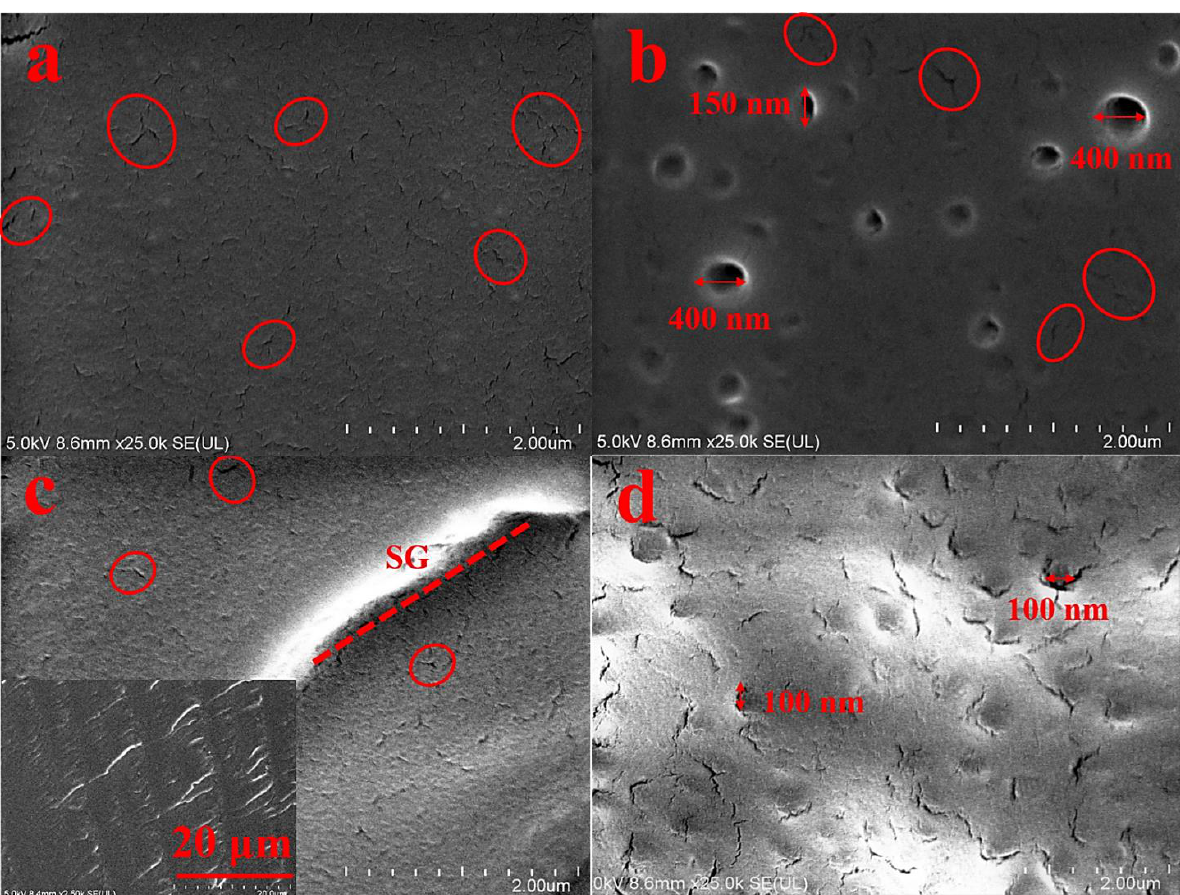
Figure 7. Micrographs of WPUA ( a ) and 0.3-SG ( c ) without immersion, and WPUA ( b ) and 0.3-SG ( d ) after immersion treatment with deionized water.